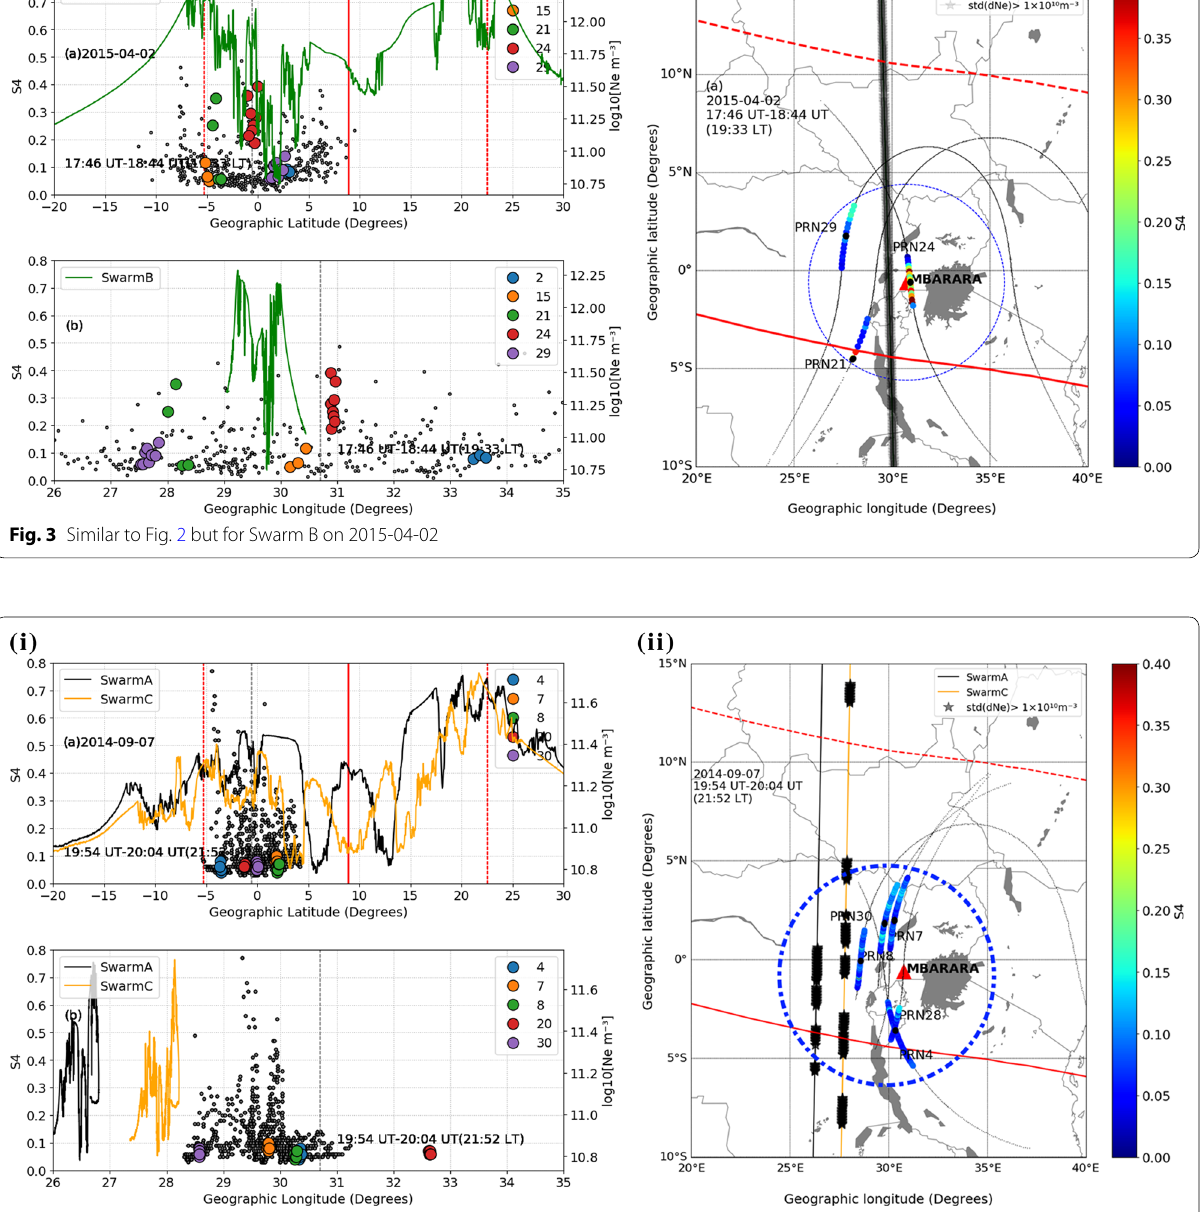
and scintillation. An example is presented in Fig. 4 for C seem to be intermittent and patchy such that the GPS signals became only moderately perturbed. Also, for the Swarm passes presented in Fig. 4, the background density was lower compared to the events shown in Figs. 2 and 3. Nishioka et al. (2011) also observed that intense in situ ionospheric irregularities recorded using C/NOFS PLP were accompanied by only mild VHF